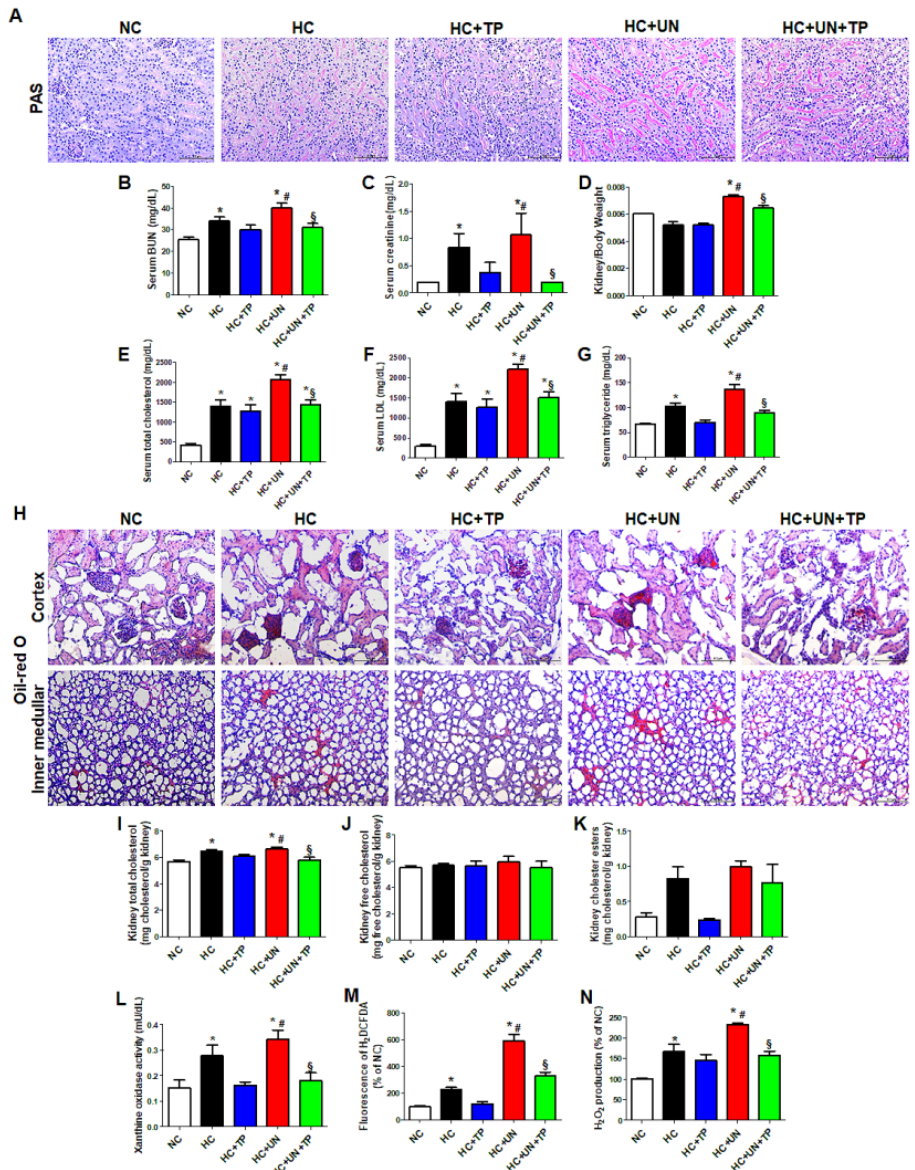
Figure 1. The e ff ects of xanthine oxidase inhibition on high-cholesterol diet-induced cholesterol accumulation, oxidative stress, and damage in the kidney. ( A ) Representative images of periodic acid Schiff (PAS) staining of kidney tissue. Scale bars, 100 μ m. ( B – D ) Levels of blood kidney injury factors (BUN and creatinine) and kidney/body weight in mice from different groups. ( E – G ) Serum cholesterol levels in mice from different groups. ( H ) Representative images of Oil red O staining of kidney tissue (upper: cortex, lower: inner-medullar). Scale bars, 100 μ m. ( I – K ) Total cholesterol, free cholesterol, and cholesterol ester levels in the kidney. ( L – N ) Xanthine oxidase activity, DCFDA, and H 2 O 2 production in kidney tissue. Differences among the groups were analyzed by a one-way non-parametric ANOVA, followed by Tukey’s multiple comparison test. Data represent mean and SEM. * p < 0.05 vs. NC, # p < 0.05 vs. HC, § p < 0.05 vs. HC+UN. TP, topiroxostat; UN, uninephrectomy; NC, normal control; HC, high-cholesterol.